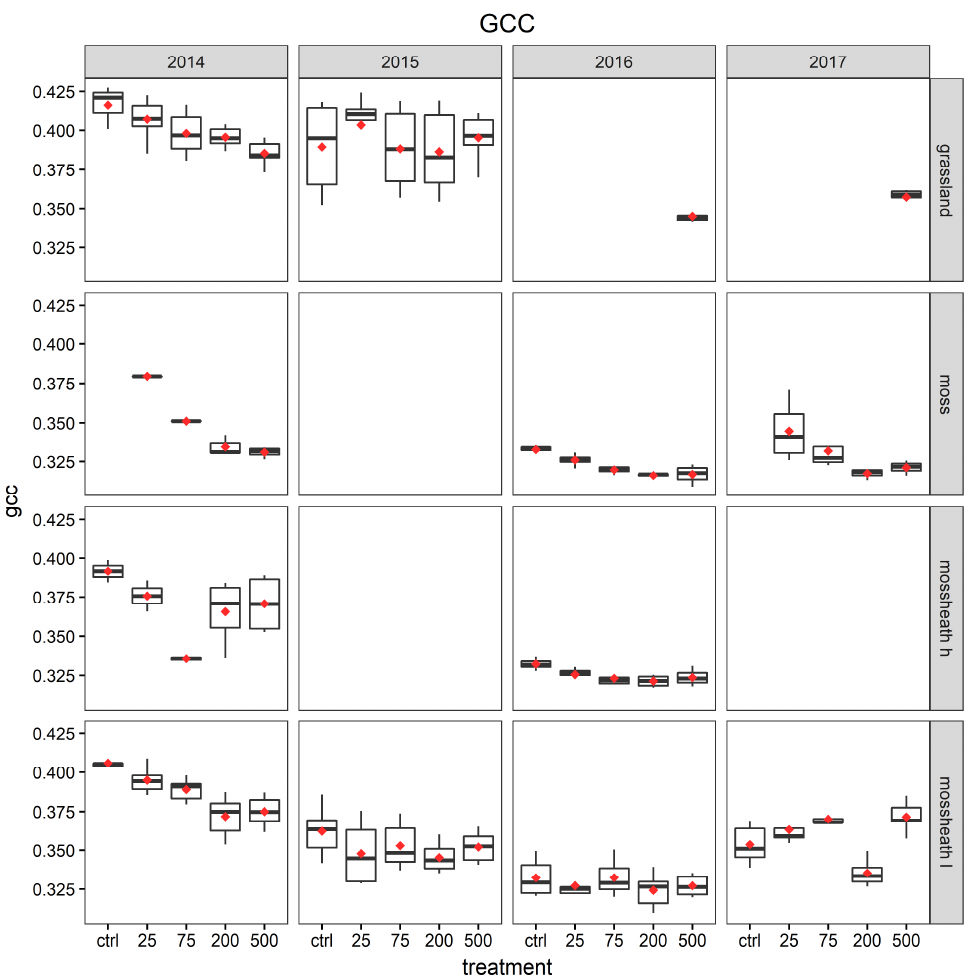
Figure 5. Vegetation greenness values, as quantified by the green chromatic coordinate (GCC) index, for the four experimental plots (i.e., grassland, moss, highland moss-heath (mossheath h) and lowland moss-heath (mossheath l)). Data is shown for four years (2014 until 2017) and five treatments classes (i.e., control (ctrl), 25, 75, 200, 500). The thick band indicates the median of all replicates, the red diamond the mean, and the bottom and top of the box indicate the 25th and 75th percentile, respectively. The ANOVA analysis showed significant di ff erences of the GCC values between the control plots and the treatment class of 200 ( p < 0.05) and of 500 ( p < 0.01) for the year 2014 (Table 2). In 2015, there were no significant di ff erences between the treatment lanes, indicating that the grassland had recovered from the hiking damages in just one